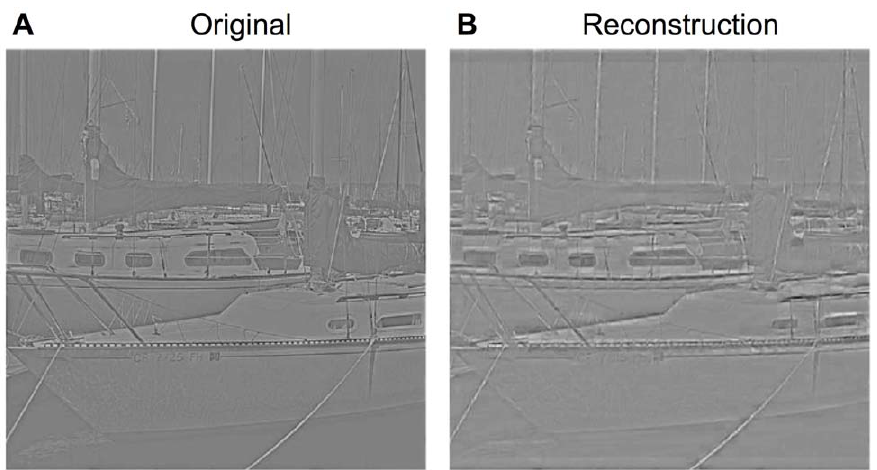
Figure 2. SAILnet activity can be linearly decoded to approximately recover the input stimulus. (A) An example of an image that was whitened using the filter of Olshausen and Field [17], which is the same filter used to process the images in the training set. The image in panel (A) was not included in the training set. (B) A reconstruction of the whitened image in (A), by linear decoding of the firing rates of SAILnet neurons, which were trained on a different set of natural images. The input image was divided into non-overlapping 16 | 16 pixel patches, each of which was preprocessed so as to have zero-mean and unit variance of the pixel values (like the training set). Each patch was presented to SAILnet, and the number of spikes were recorded from each unit in response to each patch. A linear decoding of SAILnet activity for each patch X k ~ P formed by multiplying each unit’s activity by that unit’s RF and summing over all neurons. The preprocessing was then inverted, and the patches were tiled together to form the image in panel (B). The decoded image resembles the original, but is not identical, owing to the severe compression ratio; on average, each 16 | 16 input patch, which is defined by 256 continuous-valued parameters, is represented by only 75 binary spikes of activity, emitted by a small subset of the neural population. Linear decodability is a product of our learning rules, and it is an observed feature of multiple sensory systems [42] and spiking neuron models optimized to maximize information transmission [8,12].